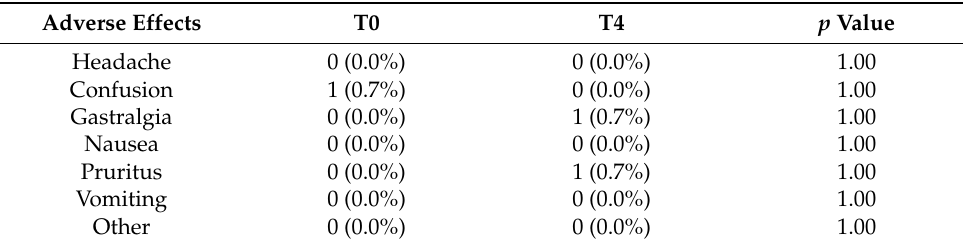
Table 4. Adverse effects attributable to BTcP medications.